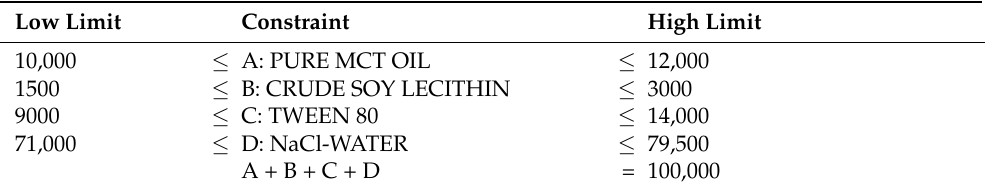
Table 1. Input variable constraints for I-optimal mixture